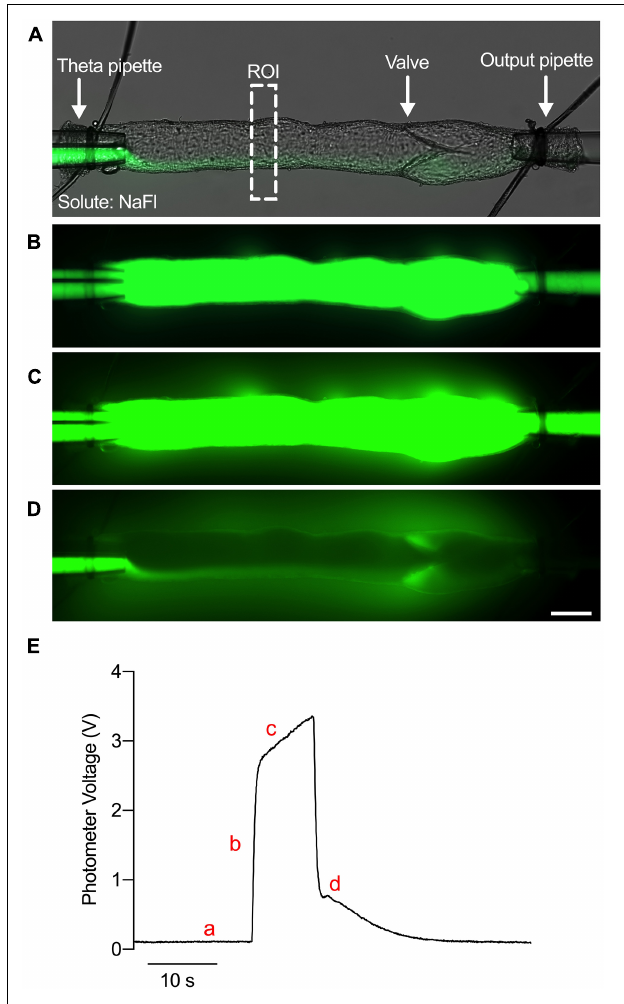
FIGURE 1 | Ex vivo assay to determine the permeability of collecting lymphatic vessels. (A) A brightfield image of an isolated, cannulated collecting lymphatic vessel from mouse mesentery with an overlaid fluorescence image of NaFl. ROI, region of interest. (B) Fluorescence image of NaFl perfusion through the lumen. (C) Fluorescence image of NaFl perfusion several seconds after the image in panel (B) depicting leakage of NaFl into the bath solution. (D) Fluorescence image of the same vessel immediately after washing out the NaFl with Krebs buffer. Extravascular NaFl can be observed. (E) A raw trace of the photometer voltage elicited by photons in the ROI during perfusion of Krebs buffer (a), immediately after perfusion of NaFl (b), several seconds after perfusion of NaFl (c), and immediately after washing out the NaFl with Krebs buffer (d). Scale bar is 100 µ m.